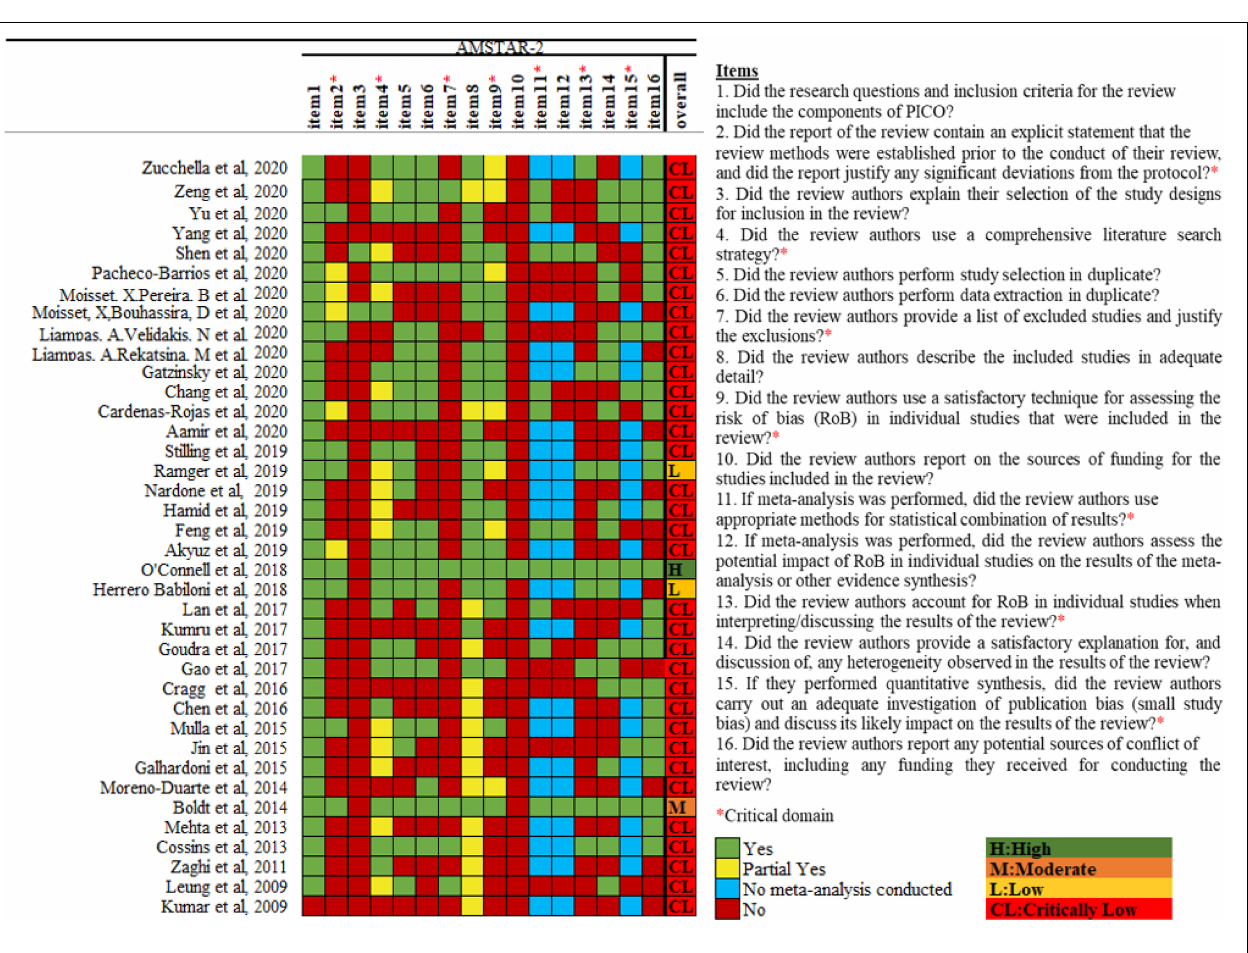
FIGURE 3 | Methodological quality of the included systematic